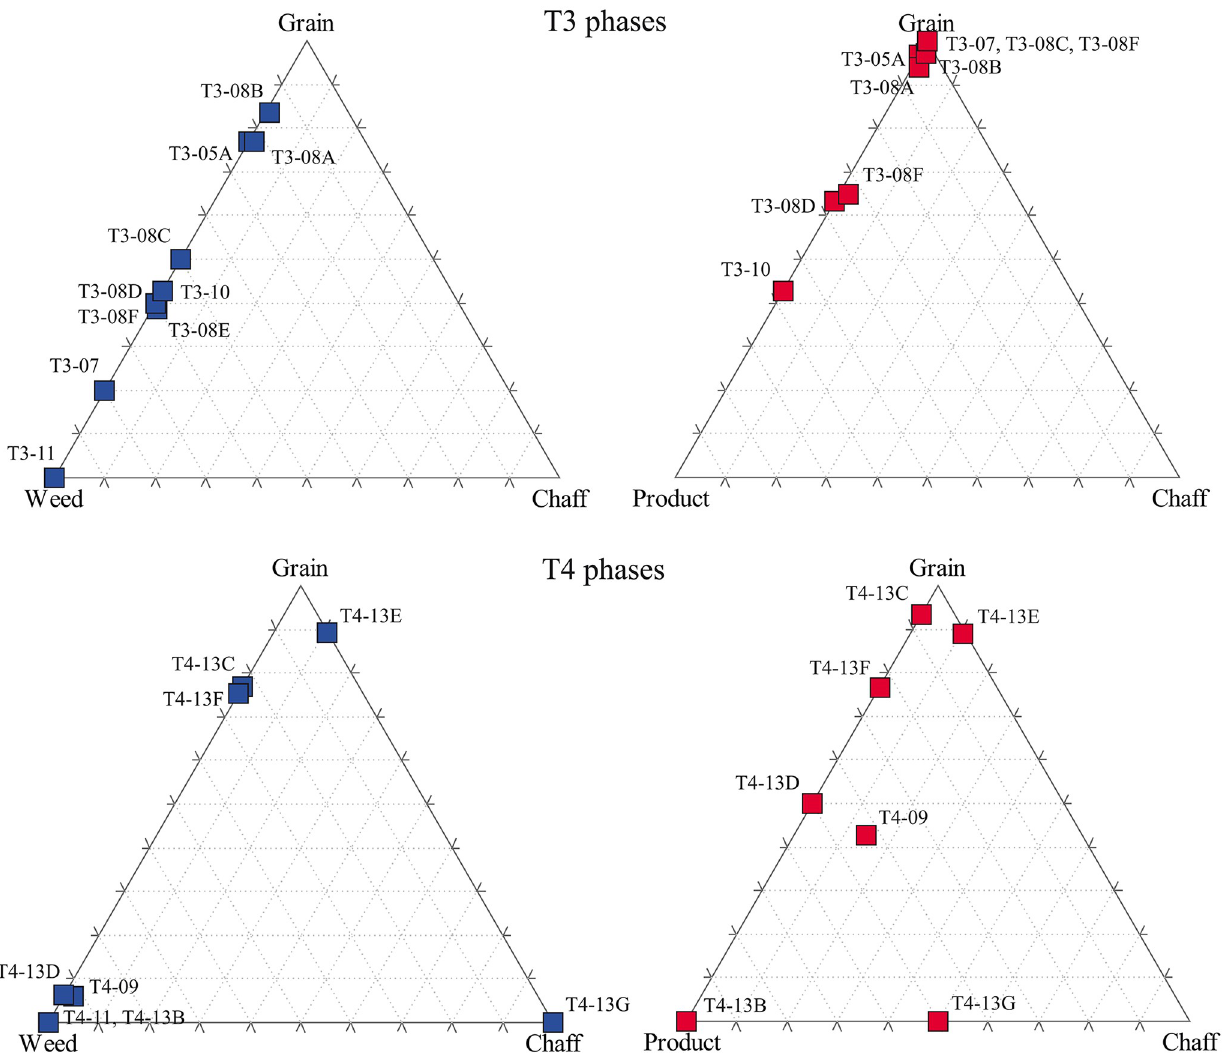
Fig 20. Ternary plots of the find assemblages by phase, as inspired by the work of G. E. Jones [68]. a) terrace T3 (n = 696), b) terrace T4 (n = 778). Left side: proportions of grain—weed—chaff, right side: proportions of grain—product—chaff. Illustration: OeAW-OeAI/A. G.